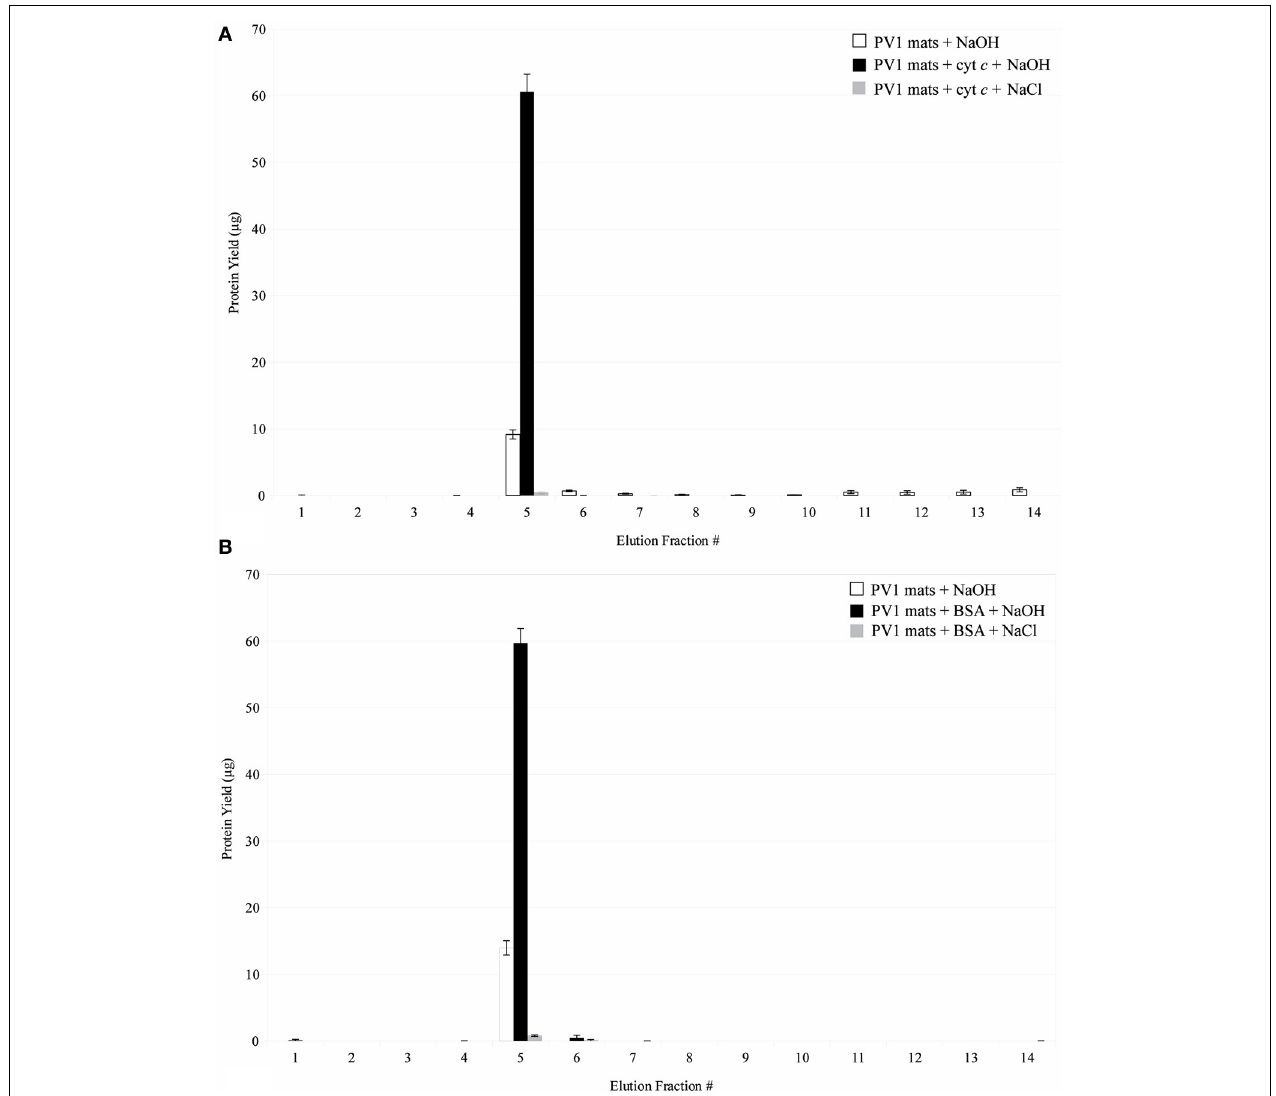
FIGURE 9 | (A) Interaction of cytochrome c with biogenic iron oxyhydroxide. Fractions 1–4 were eluted in 20mM sodium acetate buffer, pH 5.25. Fractions 5–14 were eluted in 0.1N NaOH or 1M NaCl. Error bars indicate ± one standard deviation from the mean.